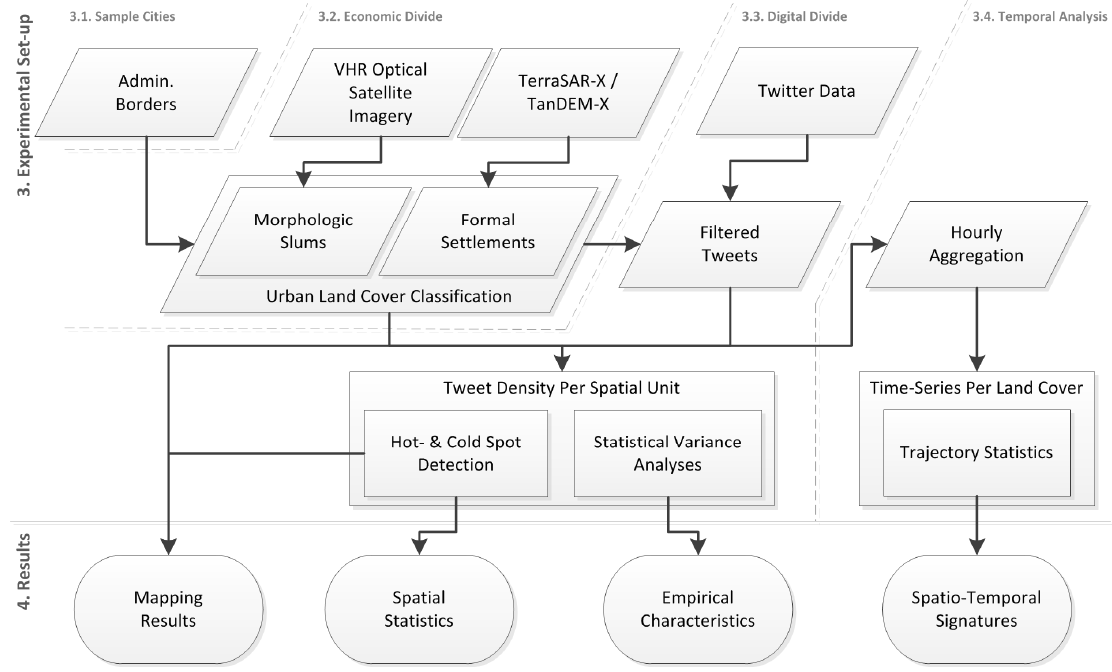
Figure 1. Workflow illustrating the experimental set-up, i.e., data, methodological steps of analysis. Beyond, the varying results are presented. All steps are explained in detail below with the chapter numberings indicating the outline in the paper.